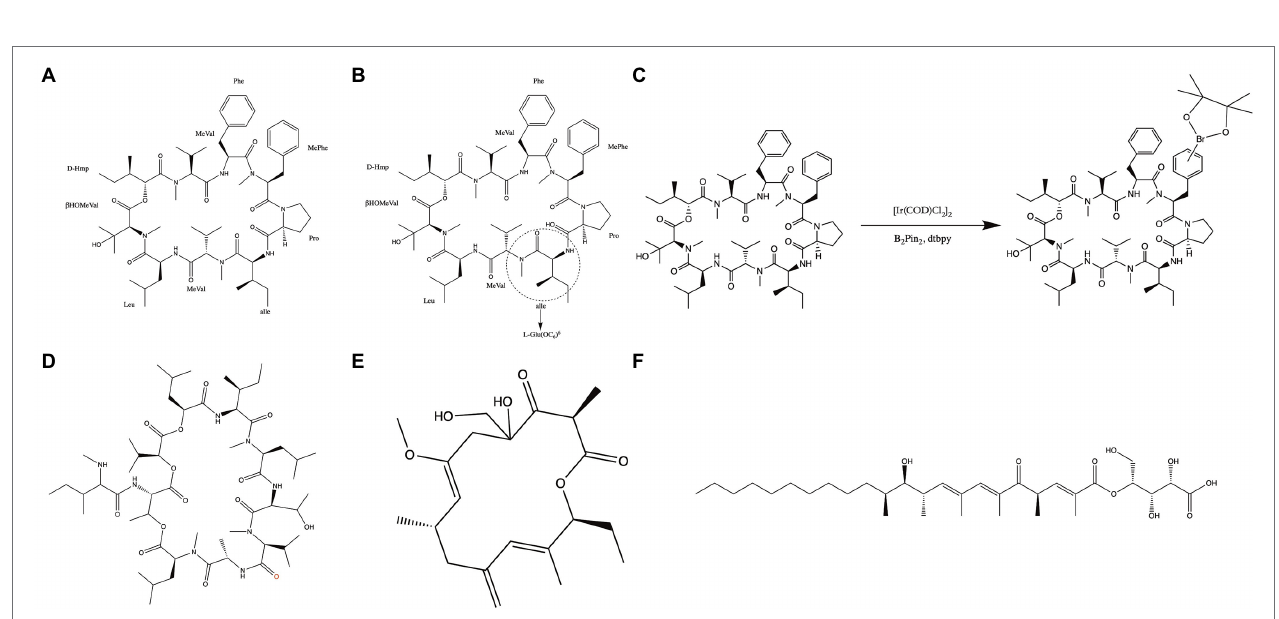
FIGURE 4 | Inhibitors of the IPC synthase. (A) Structure of Aureobasidin A; (B) structure of [L-Glu(OC 6 ) 6 ]-AbA; (C) functionalization of the phenylalanine residues in the compound by iridium-catalyzed borylation; (D) structure of Pleofungin A; (E) structure of galbonolide A; and (F) structure of